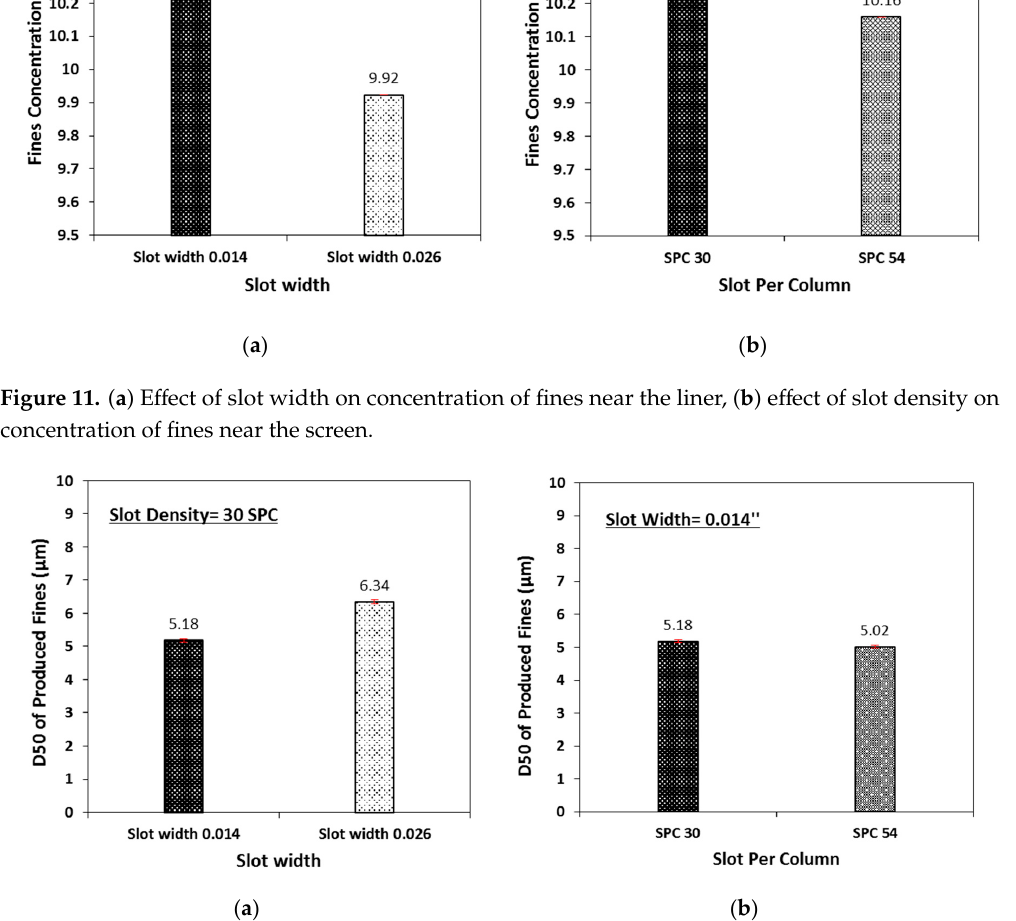
Figure 12. ( a ) Effect of slot width on the D50 of produced fines, ( b ) effect of slot density on the D50 of Figure 12. ( a ) E ff ect of slot width on the D50 of produced fines, ( b ) e ff ect of slot density on the D50 of produced fines. produced